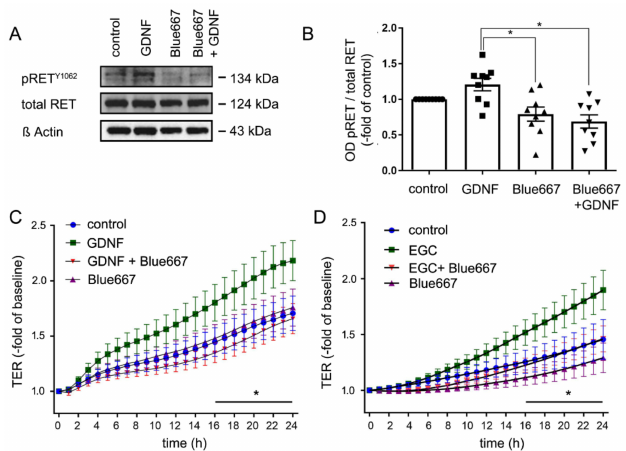
Figure 6. Effects of enteric glial cells (EGC) on epithelial barrier function are RET-dependent. ( A ). Representative Western blots of Caco2 cells are shown. Glial cell line-derived neurotrophic factor (GDNF) increased the ratio of phosphorylated RET Y1062 to 131 ± 9%- of controls, while application of Blue667 reduced basal phosphorylation of RET and blocked GDNF-induced RET phosphorylation to 67.5 ± 9% of controls; ( n = 8). ( B ). Quantification of the western blots are shown which demonstrated that GDNF increased RET phosphorylation to 131.1 ± 9% of controls whereas Blue667 reduced RET phosphorylation; ( n = 8, Kruskal Wallis Test); Control = Caco2 monolayer without treatment. ( C , D ). Transepithelial electric resistance (TER) measurements of Caco2 monolayers are shown. The inhibition of the RET by Blue667 blocked the effect of GDNF and of EGC supernatant on intestinal epithelial barrier maturation; ( n = 8 for each set of experiments; * p < 0.05; 2-way ANOVA); Control = Caco2 monolayer without